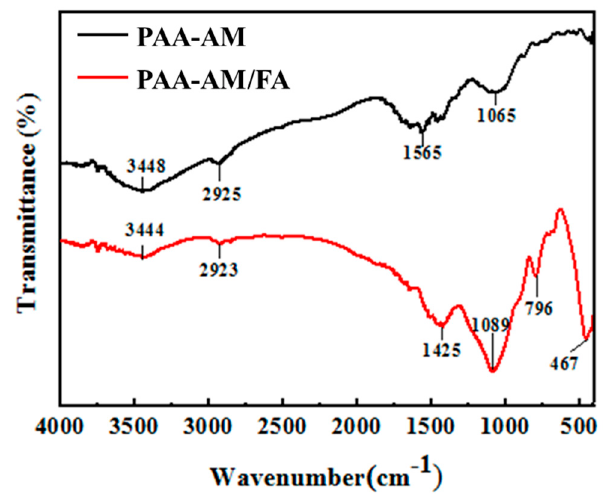
Figure 7. Fourier Transform Infrared Spectroscopy (FT-IR) spectra of PAA-AM/FA and PAA-AM.